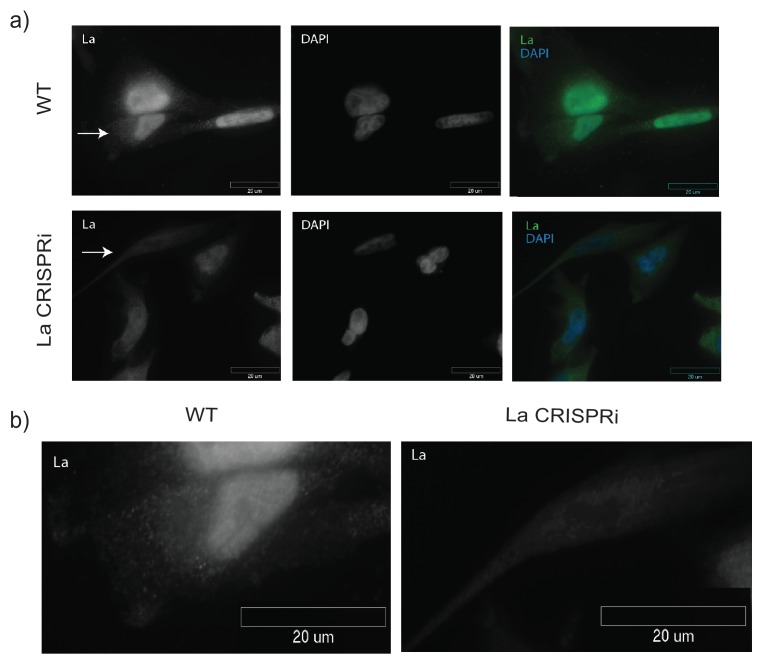
Detection of nuclear and cytoplasmic La by immunofluorescence.(a) Immunofluorescence for endogenous La was performed. WT and La-depleted cells were fixed and permeabilized with 0.1% Triton X-100. La and DAPI staining are shown. (b) Cells with arrows in (a) are shown side by side to confirm antibody specificity.